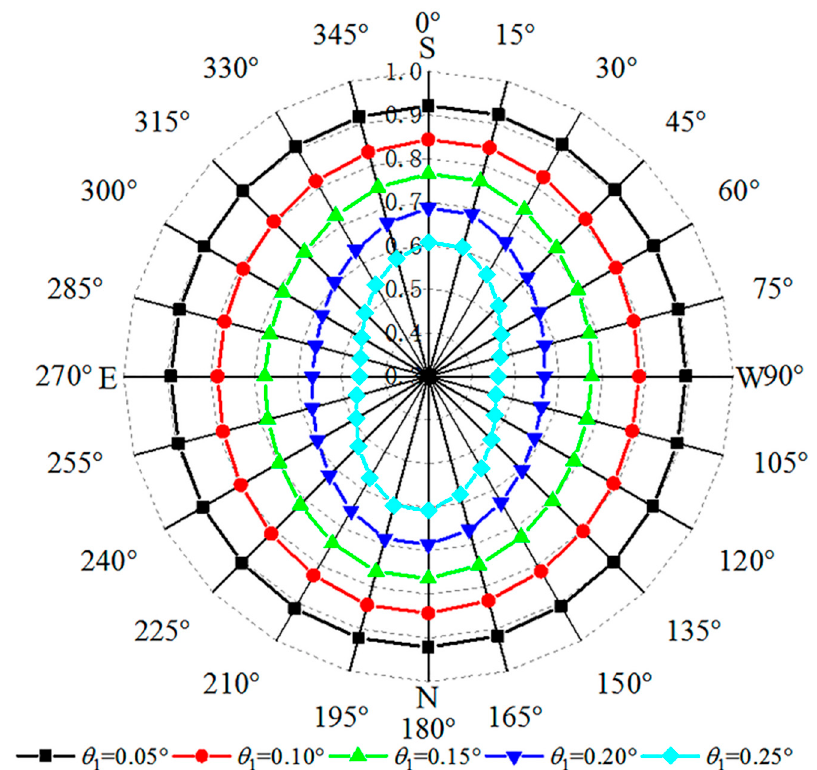
Figure 5. Variation of the effective tracking factor σ of an SDC system with the radial and tangential angles of azimuth axis.